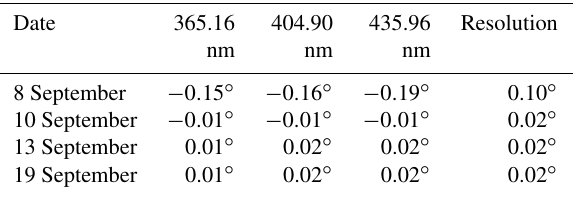
Table 2. Overview of the lamp elevations obtained for all days and different wavelengths for the MPIC instrument. Additionally, the scan resolution is indicated in the last